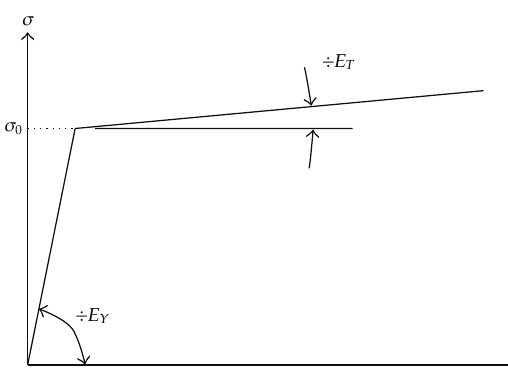
Figure 30: Stress-strain relation of steel.